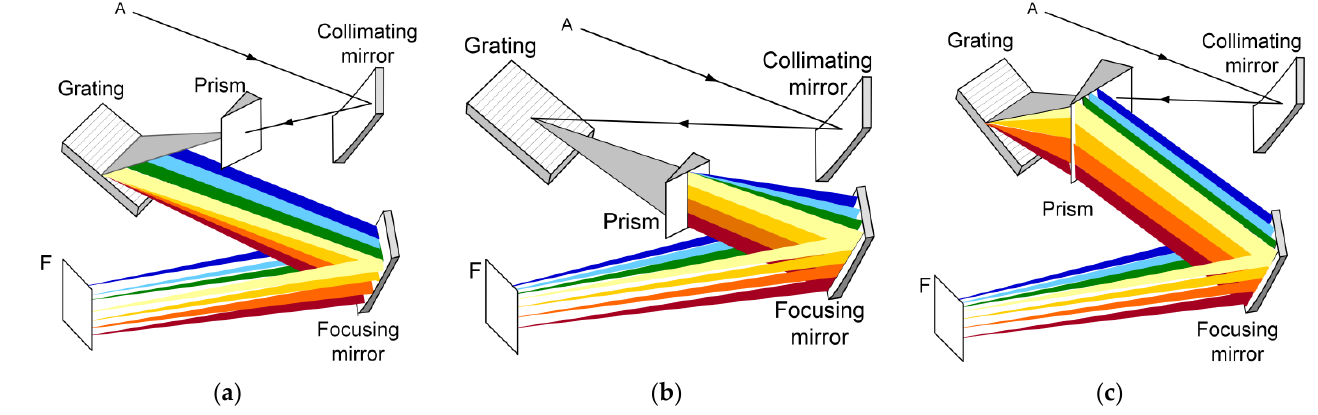
Figure 7. Three major cross-dispersion layouts. ( a ) Pre-dispersed by the prism; ( b ) Post-dispersed by the prism; ( c ) Twice-dispersed by the Prism.